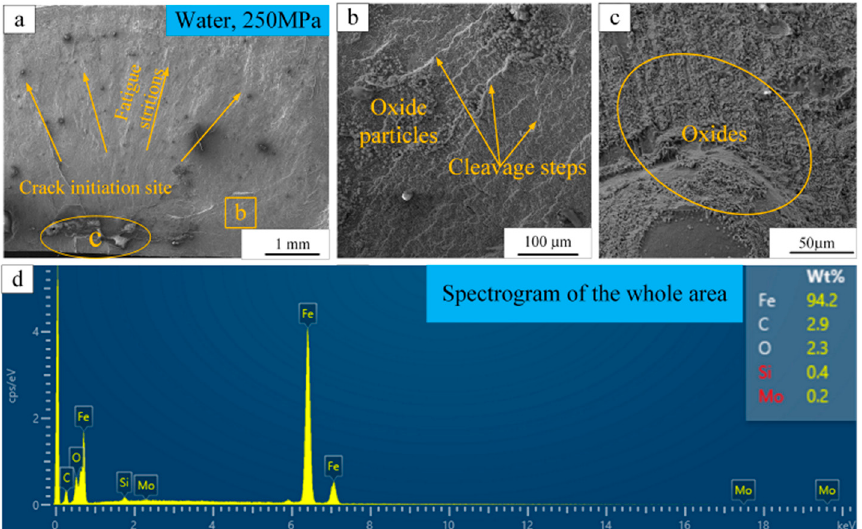
Figure 6. Fracture surface of X80 steel welded joints in water environment. ( a ) The entire fracture surface; ( b , c ) the high magnifications of the boxed areas in ( a ); ( d ) the elements distribution of ( c ).